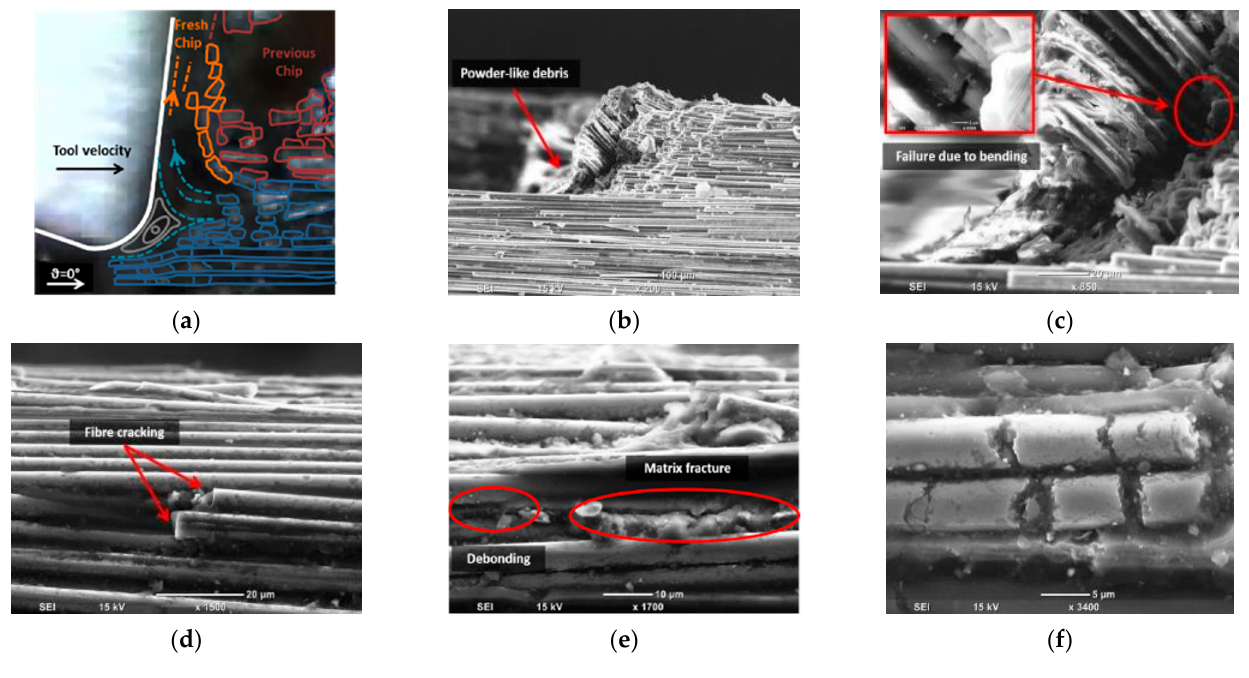
Figure 7. Chip formation for samples with a fibre orientation of 0° and a rake angle of − 10°: ( a ) a schematic diagram overlaid on a digital image, ( b ) the chip root, ( c ) a magnified SEM image of the chip root, ( d ) a side view showing fibre damage, ( e ) a side view SEM image showing matrix damage, and ( f ) a top view SEM image of the machined surface.